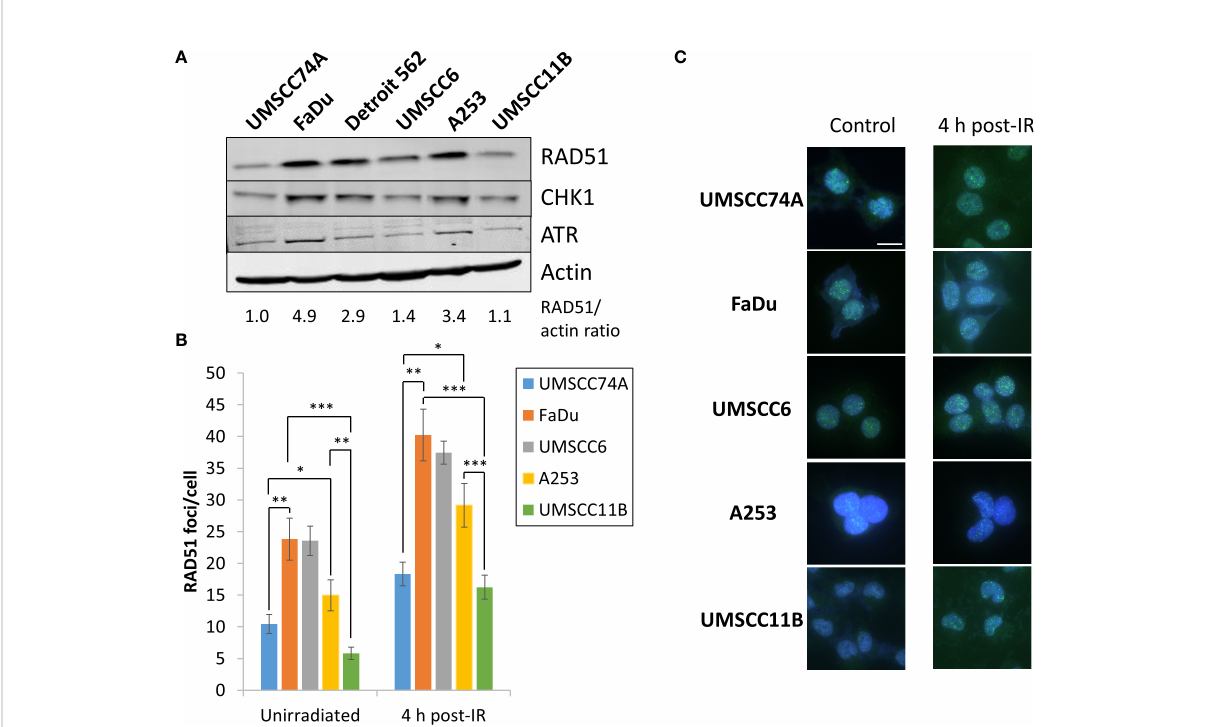
FIGURE 11 Analysis of the protein levels of HR-related enzymes in HPV-negative HNSCC cells. (A) Whole-cell extracts from HPV-negative HNSCC cells were prepared and analysed by immunoblotting with RAD51, CHK1, ATR, or actin antibodies. The ratio of RAD51 relative to actin in the cell extracts, normalised to those in UMSCC74A cells which was set to 1.0, is shown. (B, C) RAD51 foci were analysed by immuno fl uorescent staining in unirradiated HNSCC cells, and at 4 h post-irradiation (4 Gy) with x-rays. (B) Shown is the mean number of foci/nucleus with standard deviations from three independent experiments. (C) Shown are representative images of RAD51 foci (green) within cell nuclei (blue). *p < 0.05, **p < 0.001, ***p < 0.0001, as analysed by a one-sample